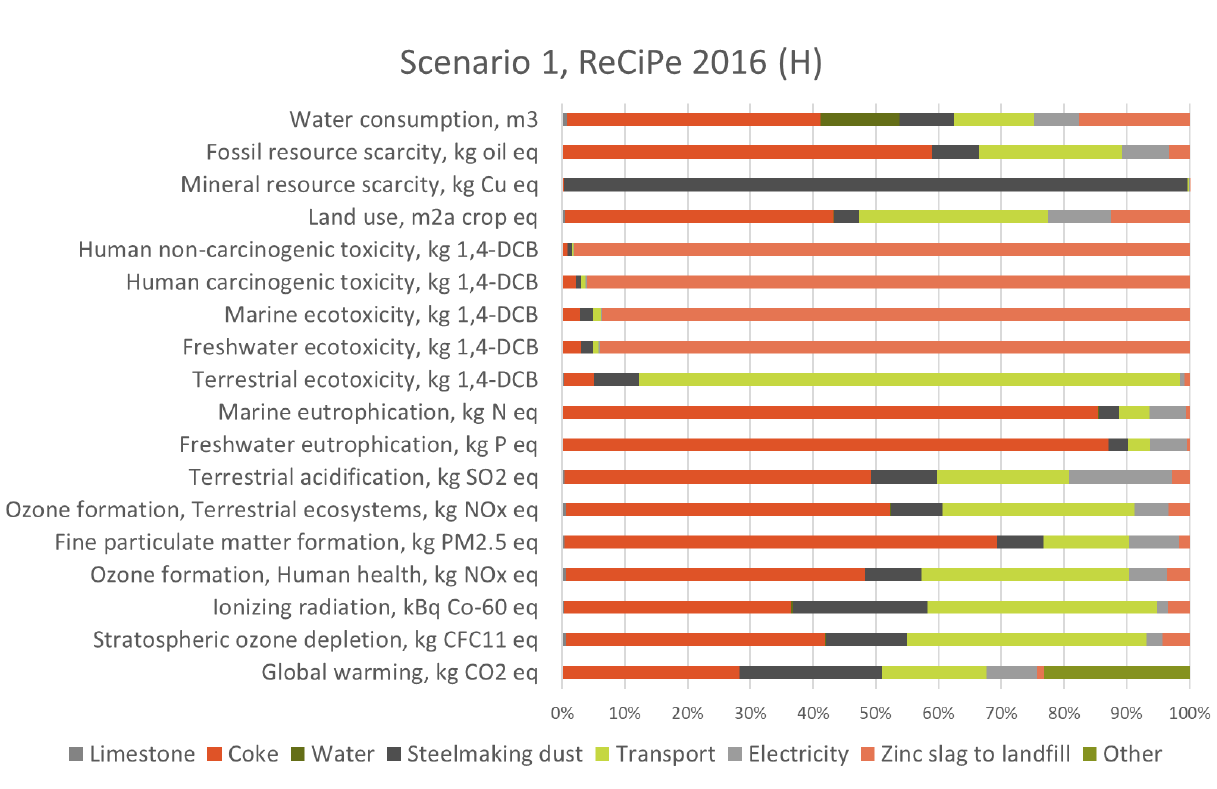
Figure 3. The contribution of the individual process in total impact scores was obtained for 18 different impact categories for scenario 1 (black mass excluded).